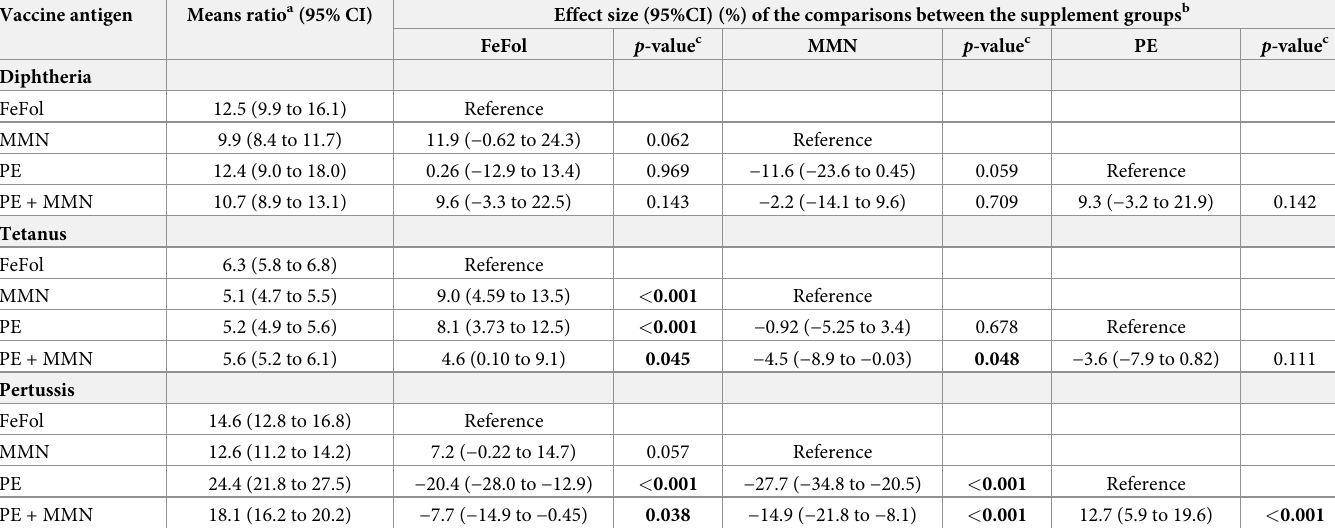
Table 4. Ratio of the means (95% CI) of diphtheria, tetanus, and pertussis antibody titres between 12 and 24